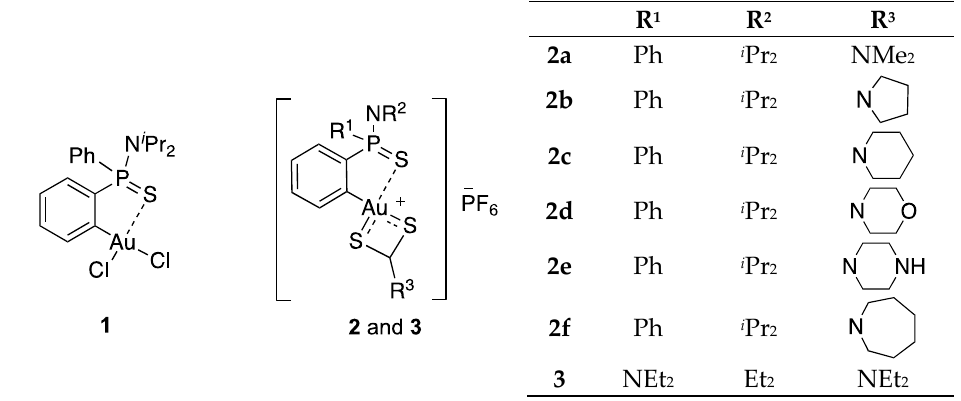
Figure 1. Structure of the complexes included in the